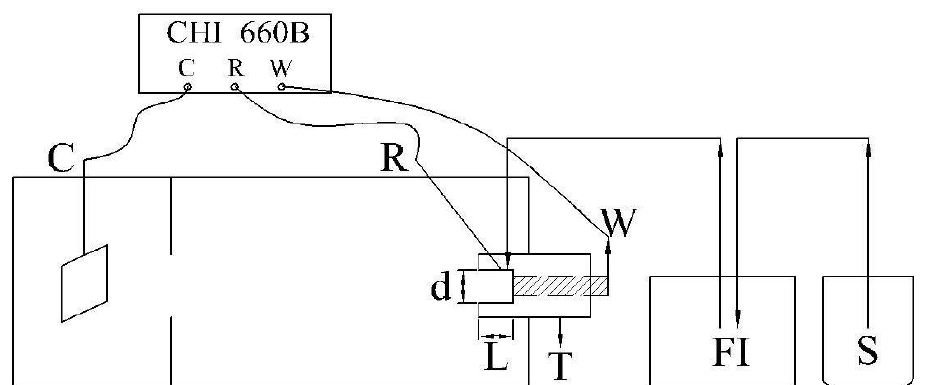
Figure 1. Schema of the experimental setup with the flow injection and the partially-closed electrode; S—injection solution; FI—flow injection; W—working electrode (iron or nickel, d = 2 mm); R—reference electrode (SCE); C—counter-electrode (Pt sheet); T—PMMA tube for the partially-closed electrode (PCE, in which L = 4 mm and d = 4 mm).